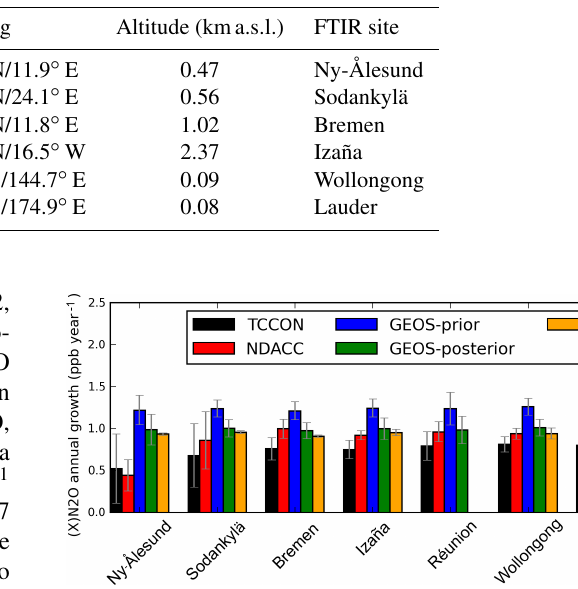
Table 6. Locations of the flask sampling data around each FTIR site. There is no flask sampling site available near Réunion.